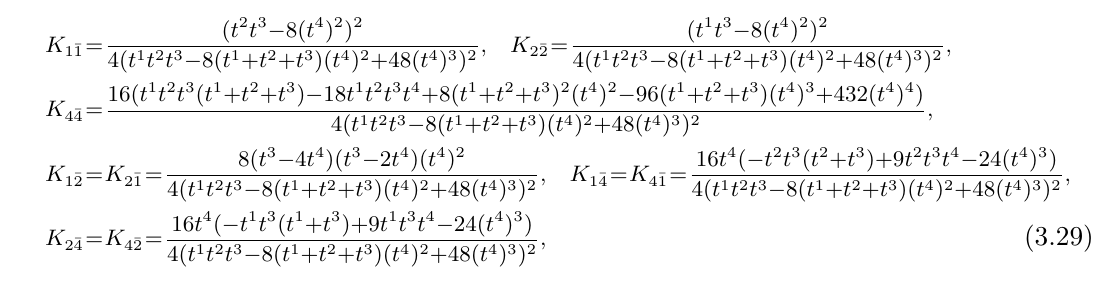
couplings, namely (i) κ